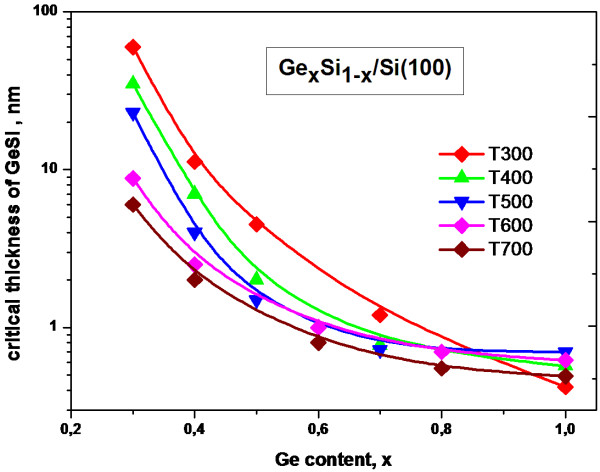
2D to 3D transition thickness of GexSi1−x layers for different Ge content and growth temperature.